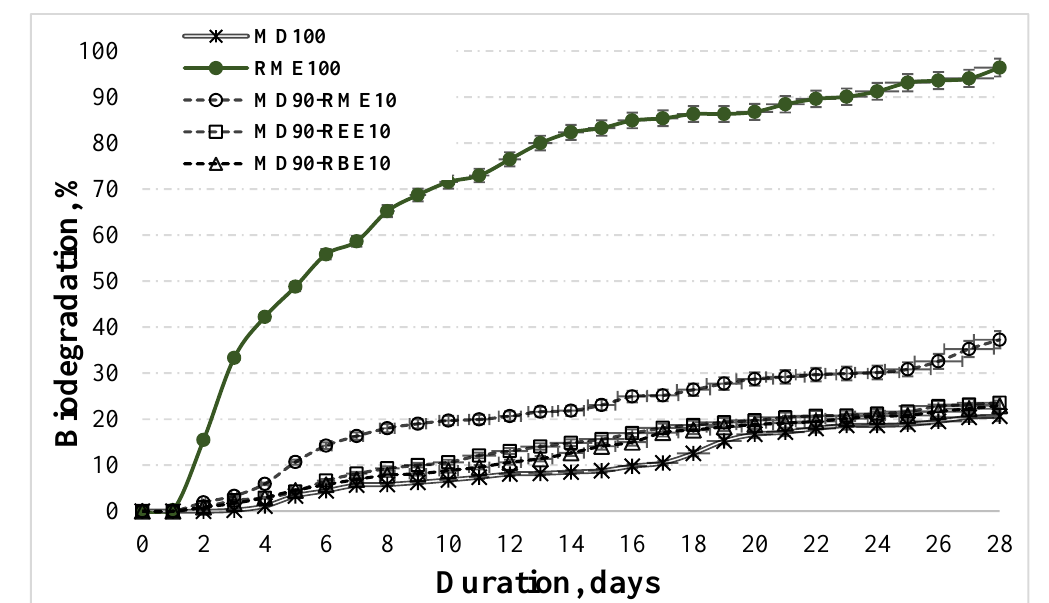
Figure 2. Biodegradation of mineral diesel, biodiesel, and fuel blends made from 90% mineral diesel and 10% rapeseed oil fatty acid methyl, ethyl, or butyl esters.